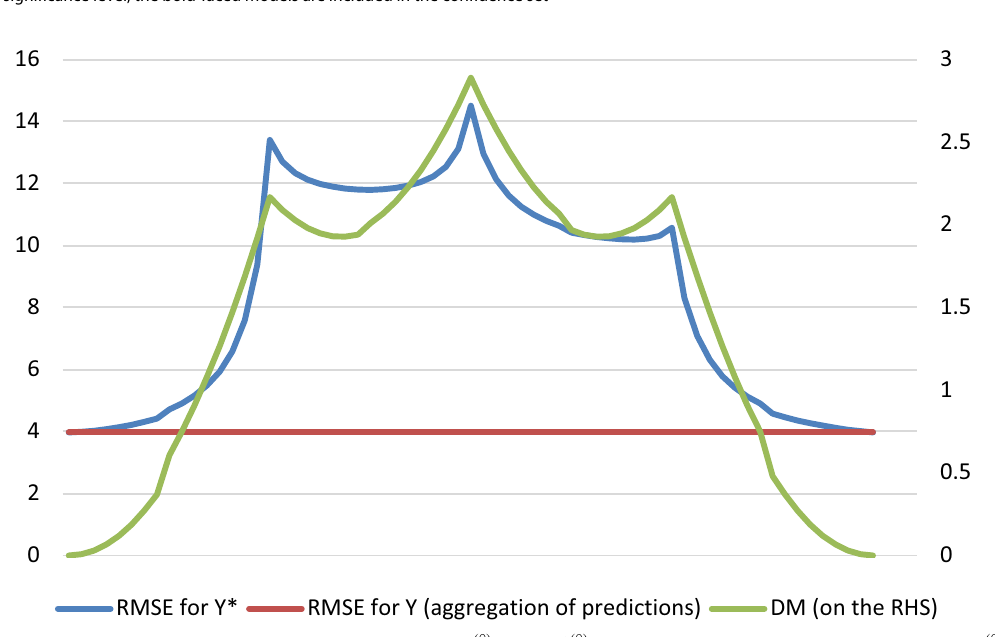
Fig. 5 Dispersion measure, DM , along with the RMSE loss function for Y ( estimated AR(1) model: Y ∗ ( aggregation of the forecasts: Y (